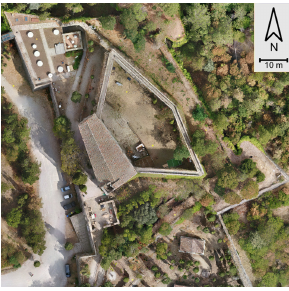
Figure 2. Orthophoto of the Girifalco